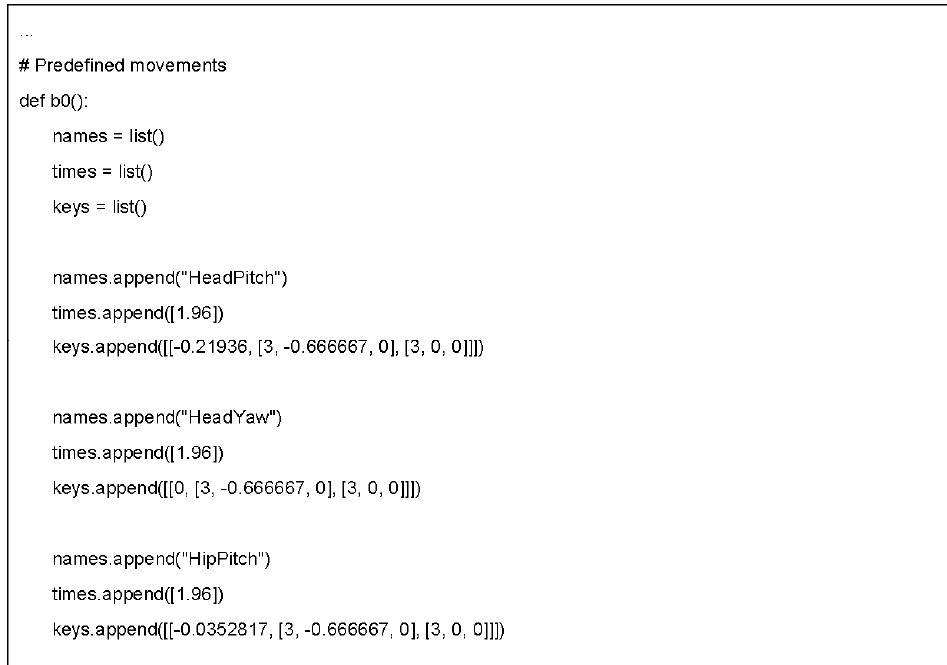
Figure 6. Script of spatial model of cultural meaning. Only the angles of the different joints of the robot were predefined as the starting point.